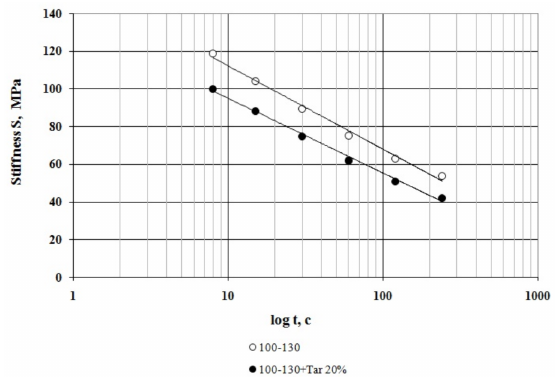
Figure 4. Stiffness variation of the virgin bitumen and the compounded one (20% of the tar) in time at the temperature of − 24 ◦ C.